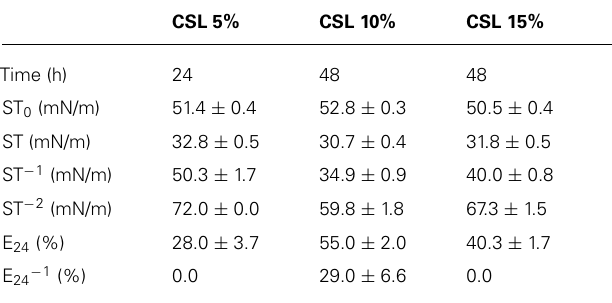
The results presented correspond to the values obtained at the optimum time for each medium. ST 0 : surface tension of the culture medium. Results represent the average of three independent experiments ±